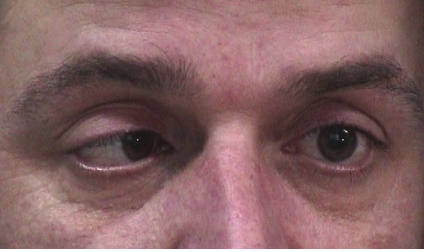
Figure 6: Underaction of left eye on laevoversion.